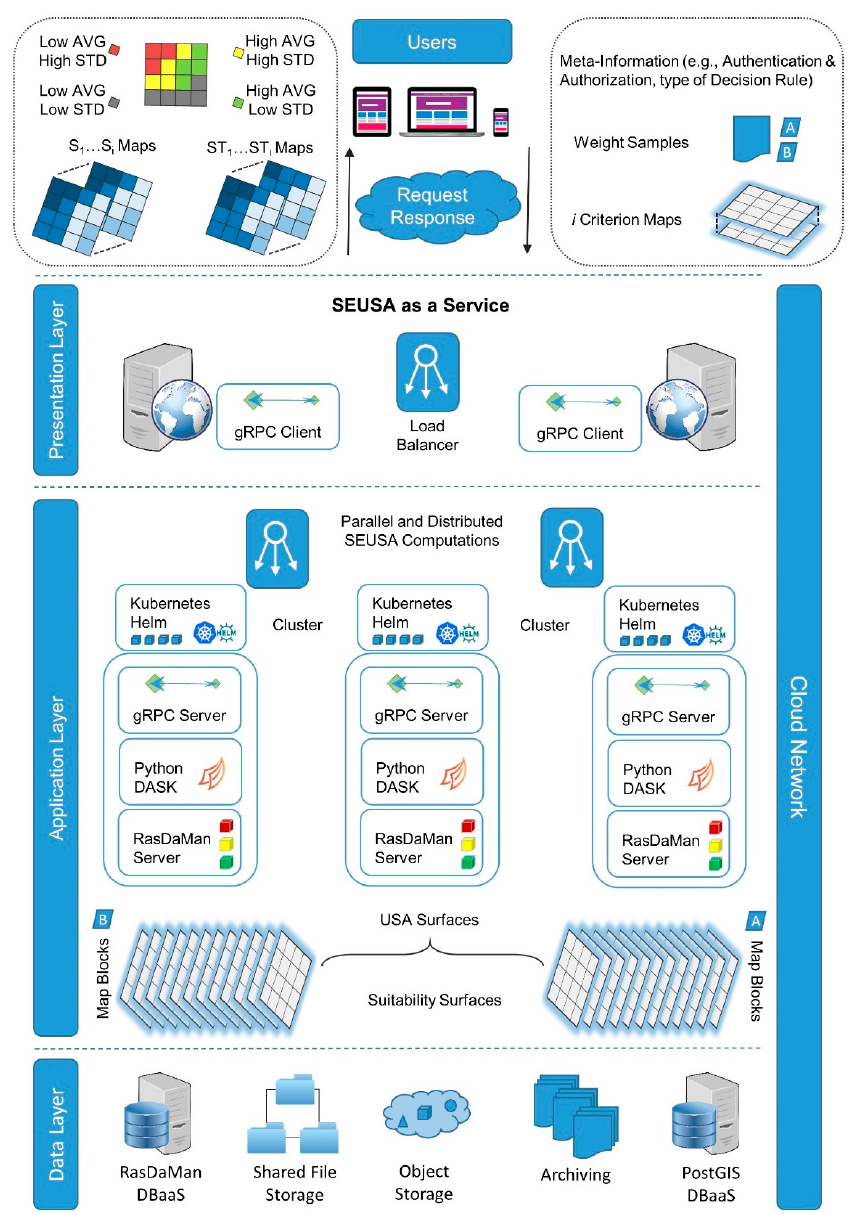
Figure 5. SEUSA as Service. Design of the Cloud-based SEUSA framework.